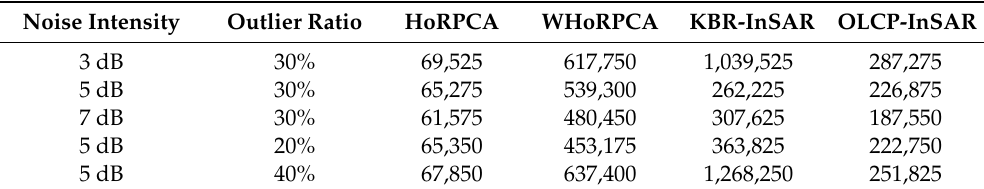
Table 2. The number of remaining residues of filtered tensors with di ff erent noise conditions.